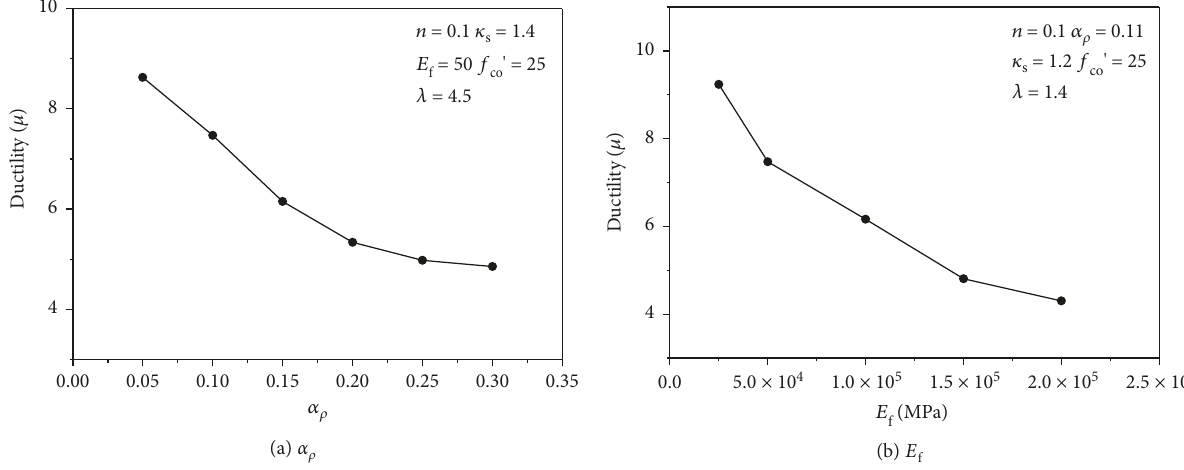
Figure 11: Variation of ductility with di ff erent